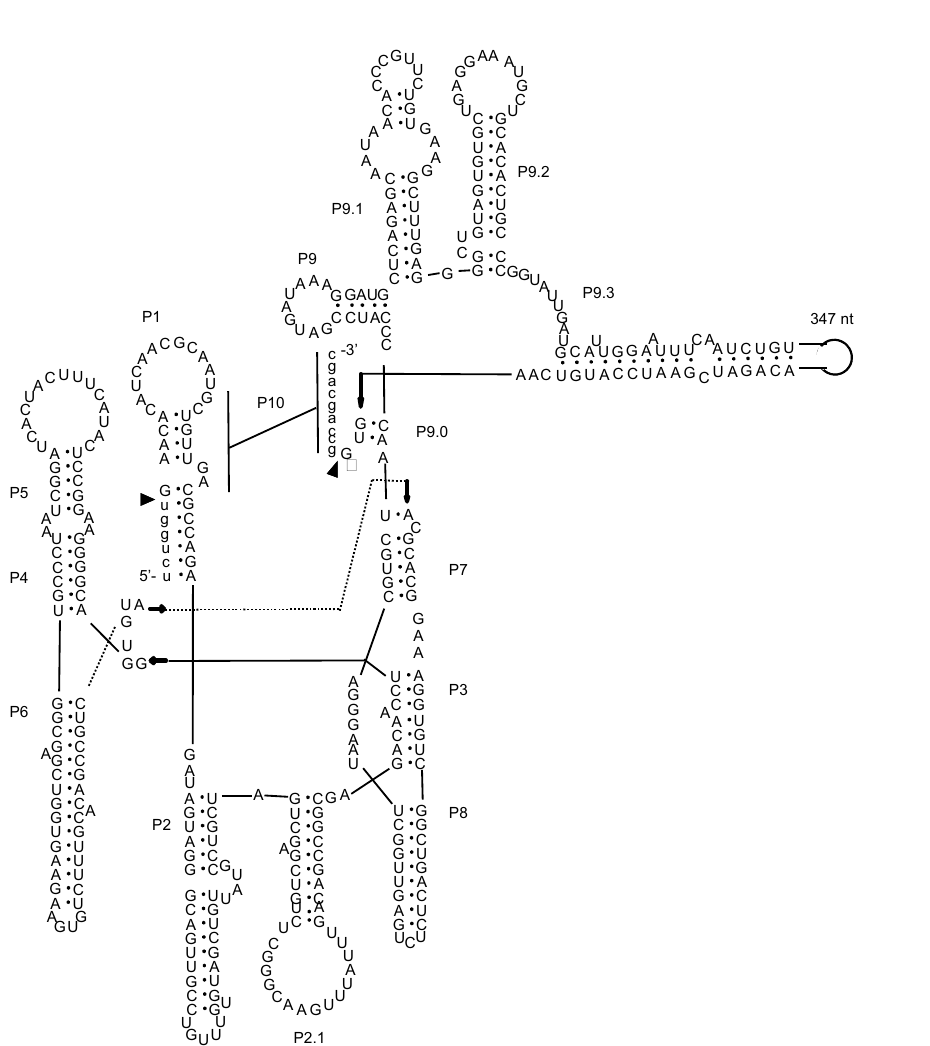
Figure 1. Predicted secondary structure of the group I intron S516 of Desmodesmus sp. nl3 , located in the 18S rDNA. Paired elements are indicated as P1 to P9, the intron sequence is in upper case letters, the exon sequence in lower case letters.